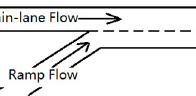
Figure 5 Scenario of merging simulation